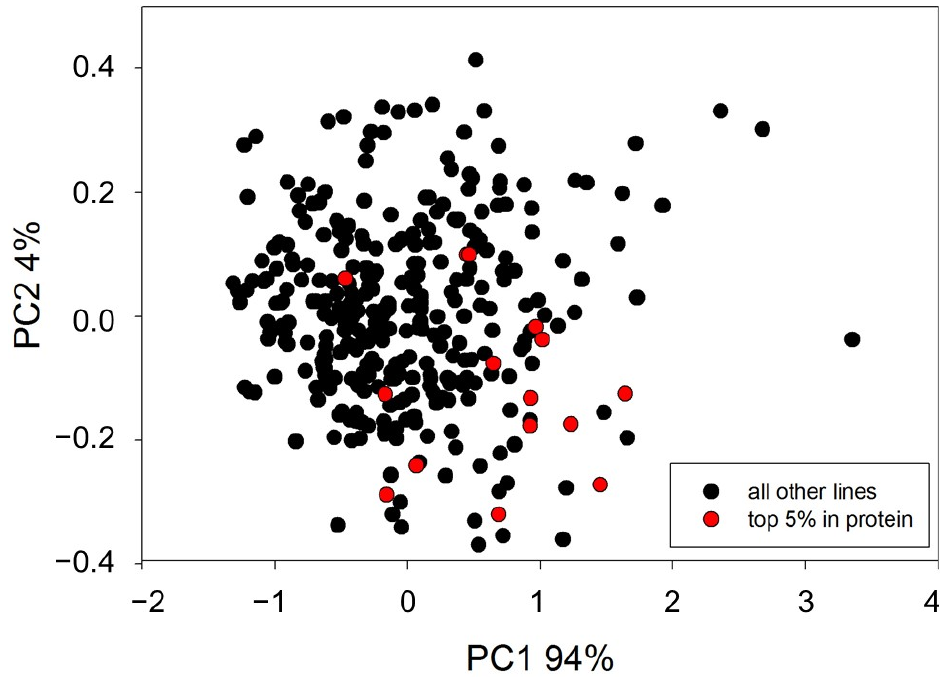
Figure 1. PCA of NIRS data on 329 mutant rice lines. Lines with seed protein in the top 5% of the total are marked in red.